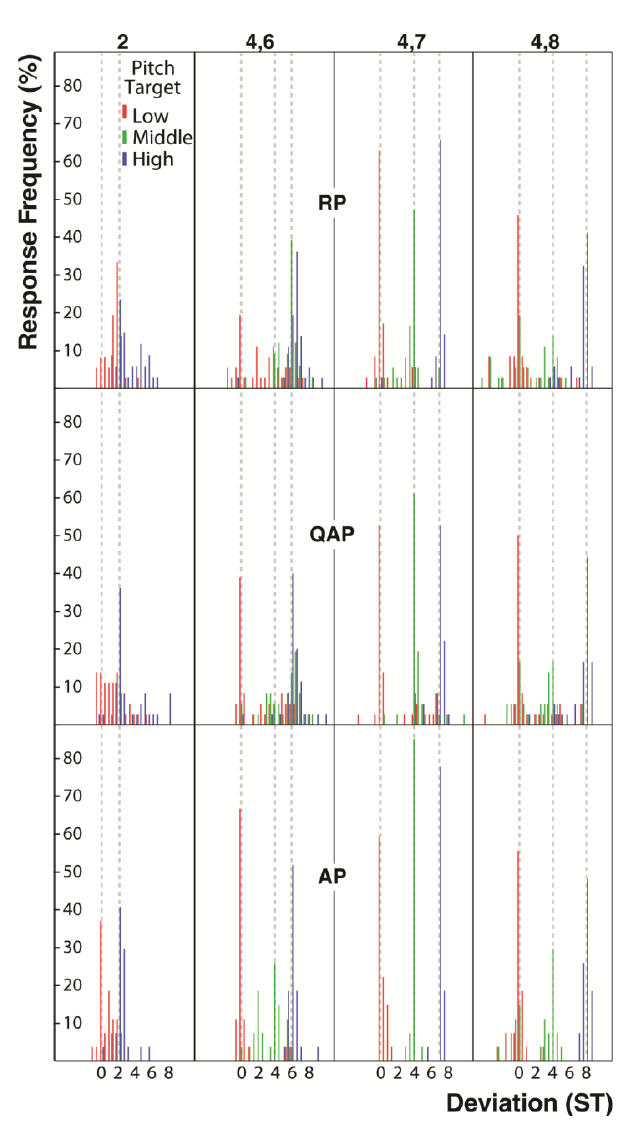
Figure 4. Histograms of pitch matching performance by each musician group for the three chords rated as most unfamiliar by all musicians (2nd, 2 semitones; flattened 5th triad, 4 and 6 semitones; augmented 5th triad, 4 and 8 semitones) contrasted with the chord rated as most familiar (major triad, 4 and 7 semitones). Grey dashed lines demark the frequency of target